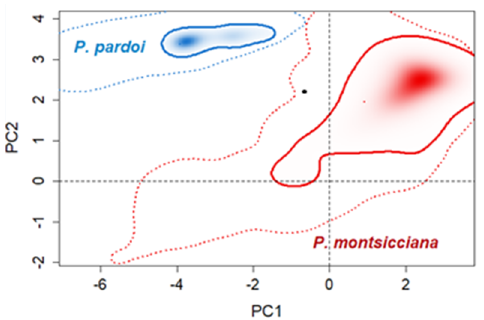
Figure 6. Global climatic space (PCA-env), projecting the realized niches of Petrocoptis montsicciana and P. pardoi in a shading gradation scale according to their density of occurrence per cell. The solid lines illustrate the 100% of occurrence density and dashed lines the 100% of background areas. Table 3. Metrics of niche dynamics comparing species pairs (1 → 2), according to definitions from [32]. Metrics are interpreted as: overlap (Schoener’s D ; 0 = no overlap, 1 = complete overlap), unfilling (0 = totally filled, 1 = totally unfilled), stability (0 = non-stabilized, 1 = totally stabilized), expansion (0 = in equilibrium, 1 = fully in expansion). Abbreviations used: PM = Petrocoptis montsicciana , PP = P. pardoi . Niche Overlap ( D )